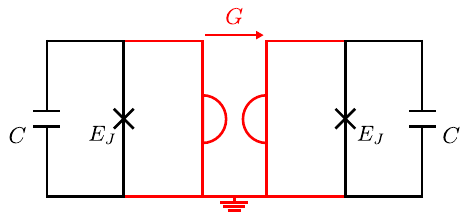
FIG. 1. Proposed hardware implementation of the GKP code. The circuit consists of two Josephson junctions coupled by a gyrator, highlighted in